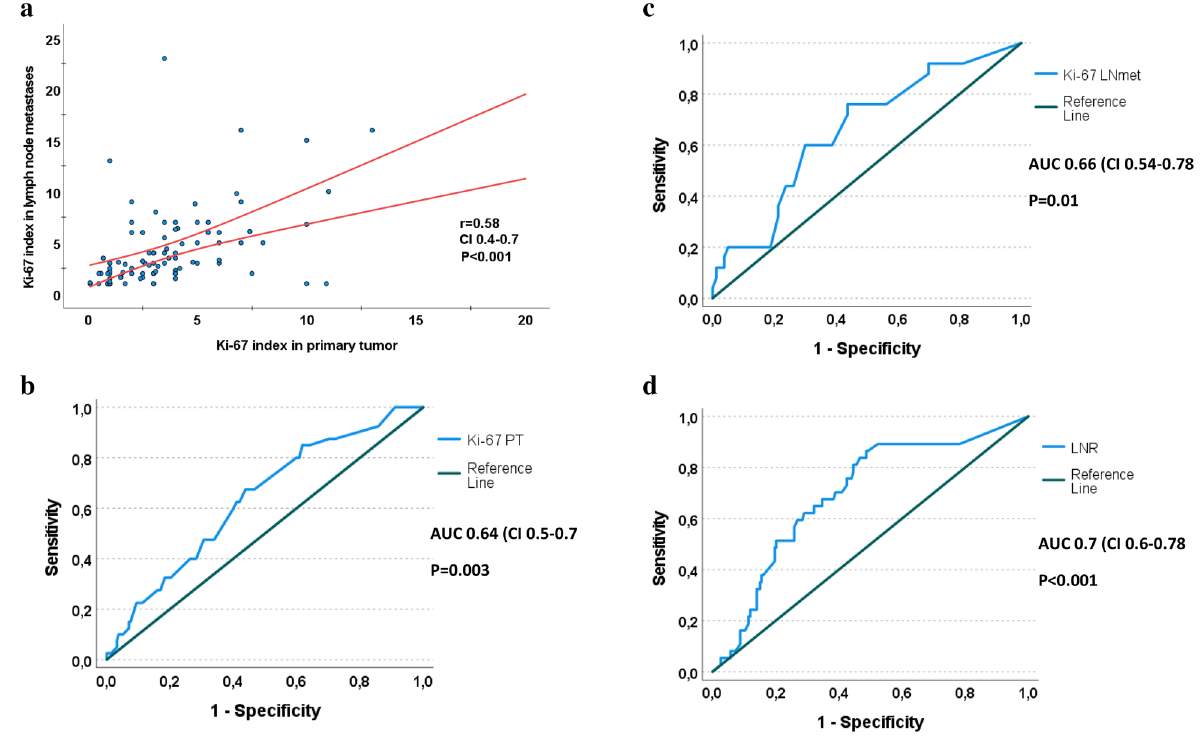
Figure 2. The relationship between Ki-67 labeling index and thyroglobulin expression in papillary thyroid cancer. ( a ) Scatter plot showing the relationship between the Ki-67 index in the primary tumors and their matching lymph node metastases. Receiver operating characteristic (ROC) curves illustrating the ability of the Ki-67 index in ( b ) primary tumors (PT) and ( c ) lymph node metastases (LNmet), and ( d ) lymph node ratio (LNR) in predicting tumor recurrence of papillary thyroid cancer. The highest AUC identified for Ki-67 ≥ 2.45% in primary tumors was 0.64, with a sensitivity of 68% and specificity of 56% (CI 0.5–0.7, p = 0.003). For the Ki-67 index in lymph node metastases, a labeling index of ≥ 2.85% was predictive for tumor recurrences with a sensitivity of 76%, specificity of 52%, and AUC of 0.66 (CI 0.54–0.78, p = 0.01). Lymph node ratio ≥ 21% was predictive for tumor recurrence with a sensitivity of 81%, specificity of 60%, and AUC 0.7 (CI 0.6–0.78, p < 0.001). ANOVA analysis evaluating the correlation between thyroglobulin expression and Ki-67 index in primary PTC ( e ) and their paired lymph node metastases ( f